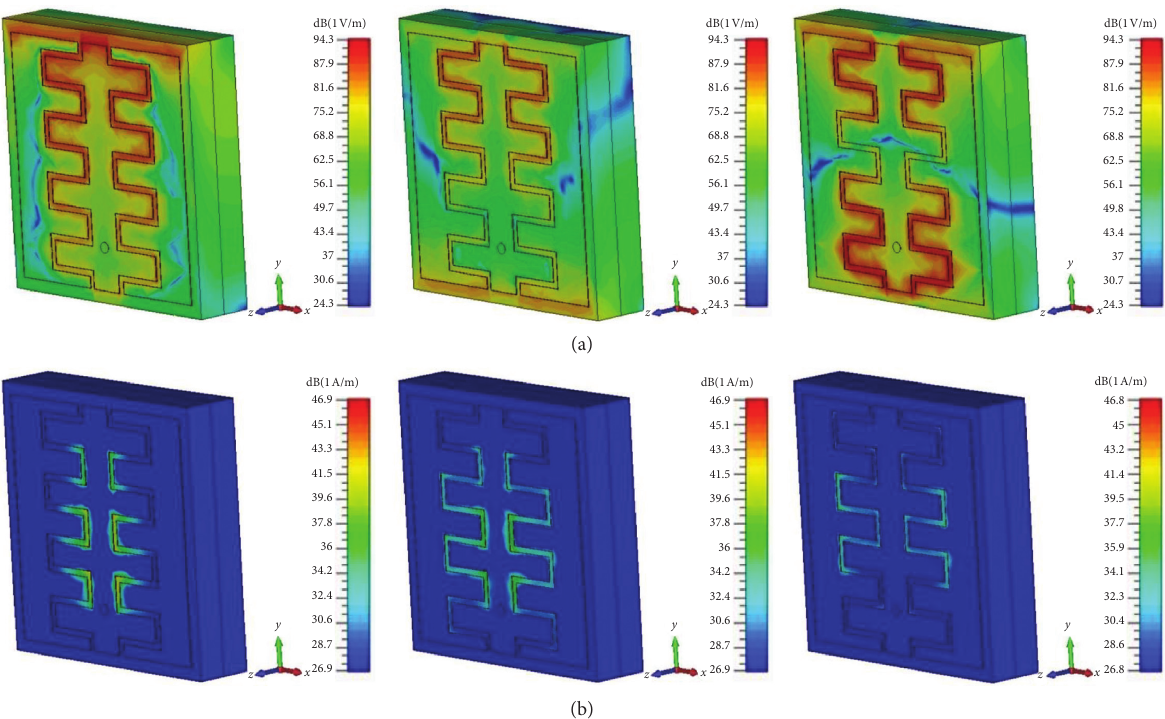
Figure 8: The simulation results of ICPW-EBG unit cell at 1.8GHz, 2.45GHz, and 3.7GHz. (a) Electric field results. (b) Magnetic field results.